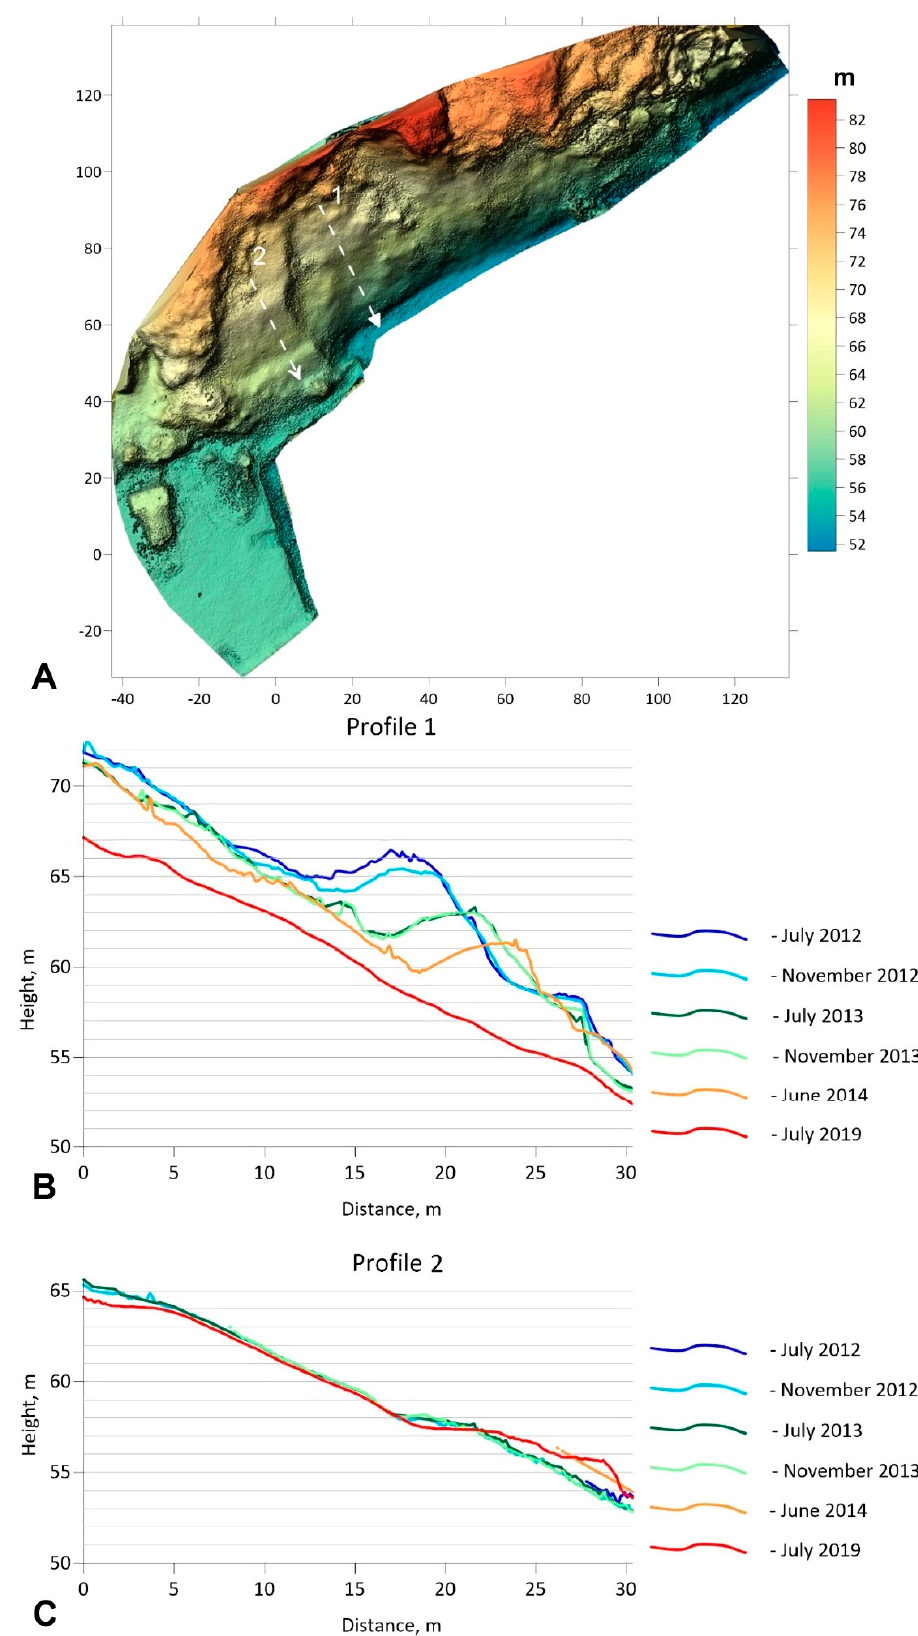
Figure 8. Site 1. 3D-model (2019) with location ( A ) of slope profiles 1 ( B ) and 2 ( C ) of the abrasion- slope at site 1.